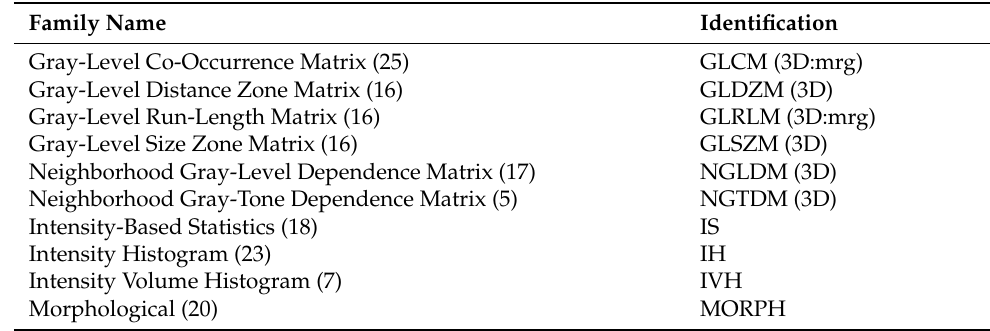
Table 2. SIBEX software radiomics family name and their IBSI identification [16,17]. 3D = three ‐ dimensional; mrg = merged. The number in rounded brackets refers to the total number of features considered in that family.